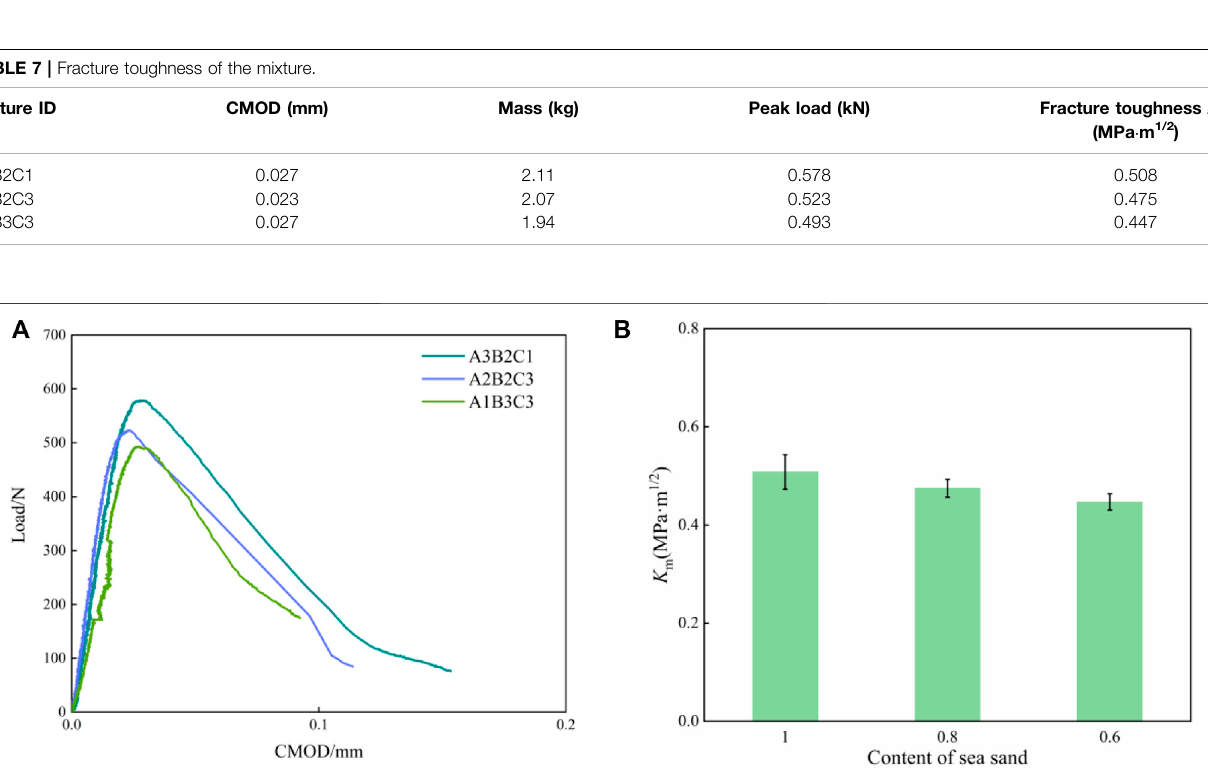
FIGURE 7 | (A) Load – CMOD curve of specimens and (B) K m of the mixture under the three-point bending load.